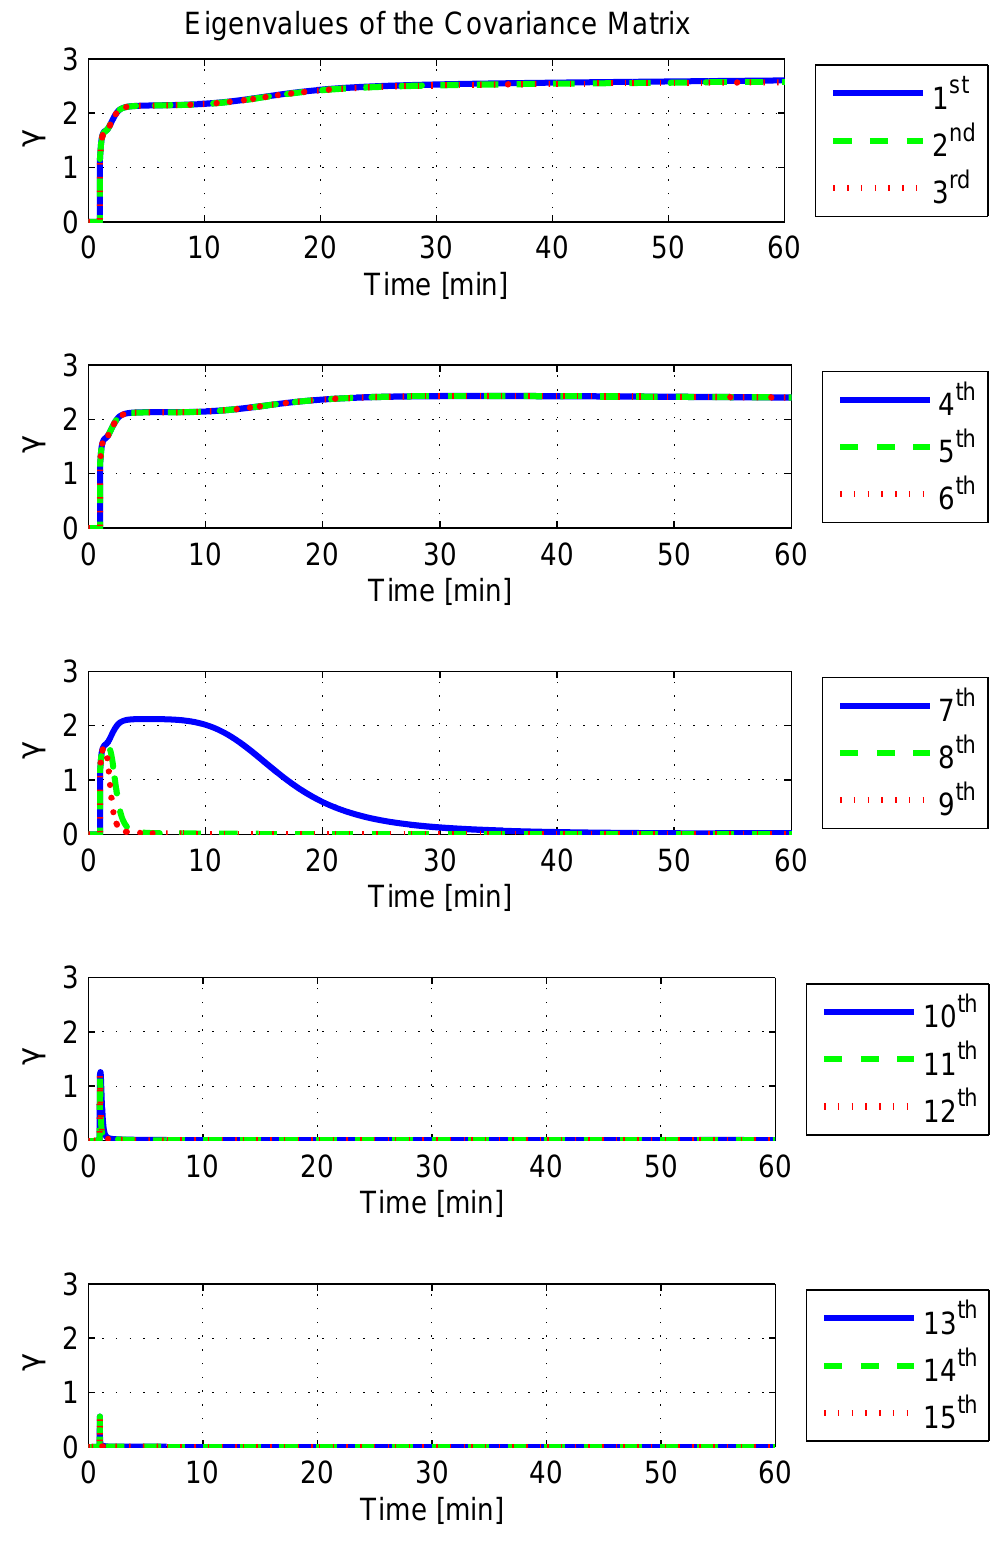
Figure 15. Eigenvalues of the covariance matrix in the experimental